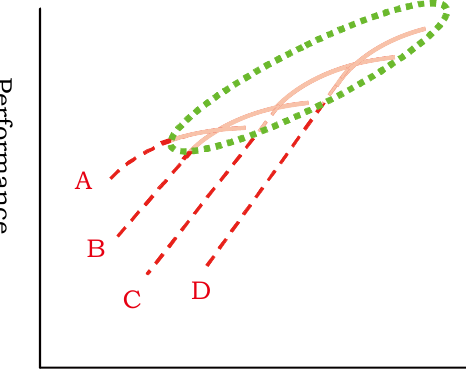
Figure 2. Disruptive technological